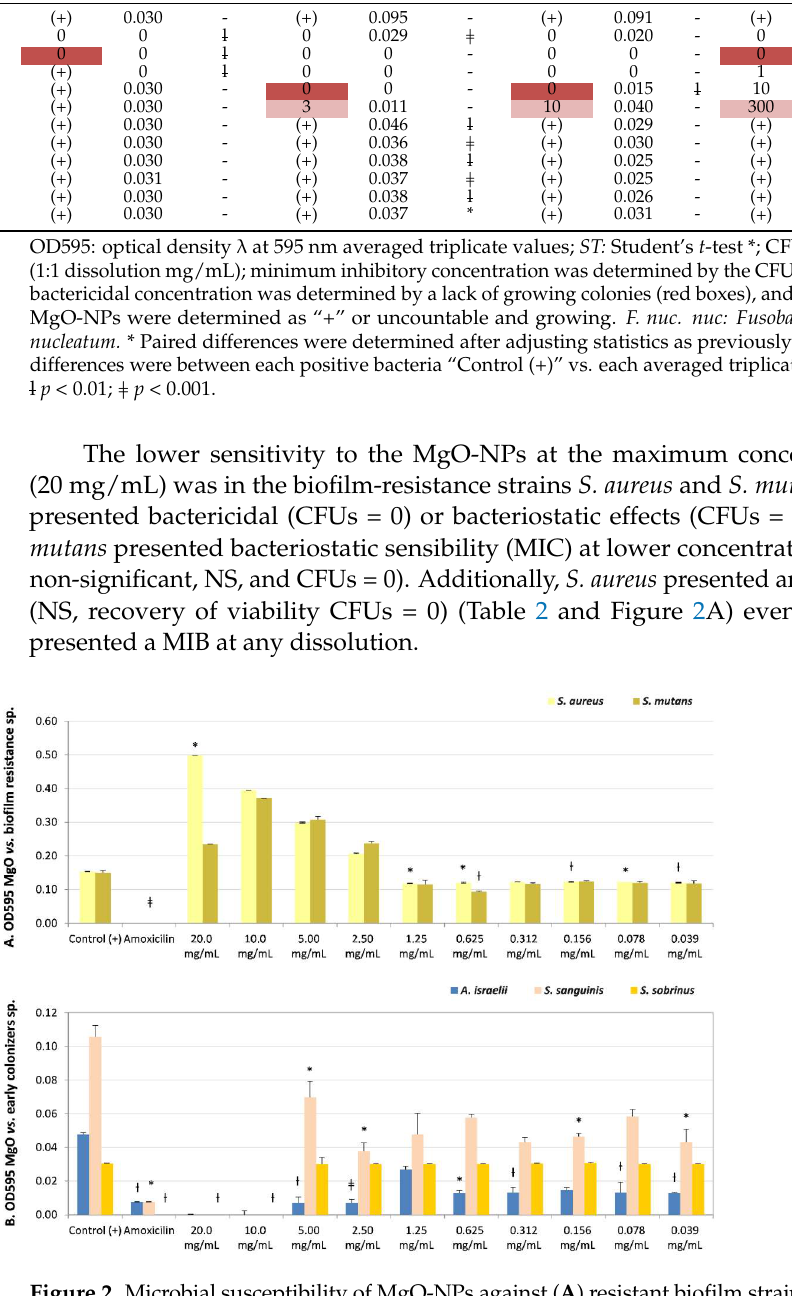
Figure 2. Microbial susceptibility of MgO-NPs against ( A ) resistant biofilm strains Staphylococcus aureus and Streptococcus mutans . ( B ) Early colonizers were Actinomyces israelii, Streptococcus sanguinis, and Streptococcus sobrinus . OD595: optical density λ at 595 nm averaged triplicated values; Control (+): bacteria positive control, Amoxicillin: inhibition control, and MgO dissolution used (20 mg/mL to 0.039 mg/mL). Paired differences were determined by Student’s t -test after adjusting per triplicate results as previously described by [27]. The difference between each strain Control + versus each plate dilution is shown as * p < 0.05; ƚ p < 0.01; ǂ p < 0.001. S. sanguinis (Table 2 and Figure 2B) (early colonizer), with one of the later colonizer biofilm strains P. gingivalis or a periodontopathogen strain (Table 2 and Figure 3B), re- ported no recovery of viability with CFUs = 0 until the maximum concentration evaluated (20 mg/mL). However, P. gingivalis presented bacteriostatic sensibility at a lower concen- tration of 2.50 mg/mL (NS, CFUs = 300).